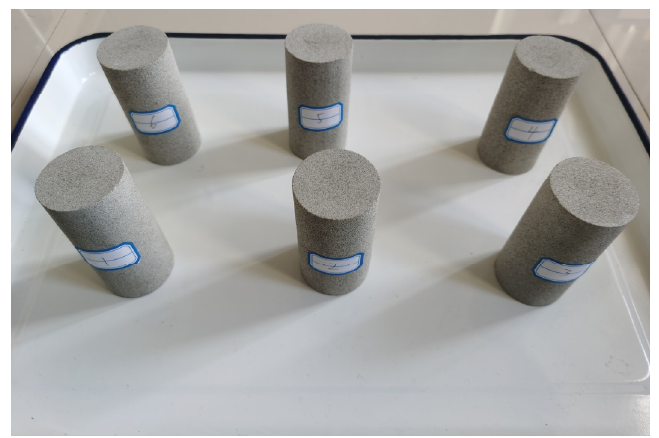
Figure 1. Rock specimen.